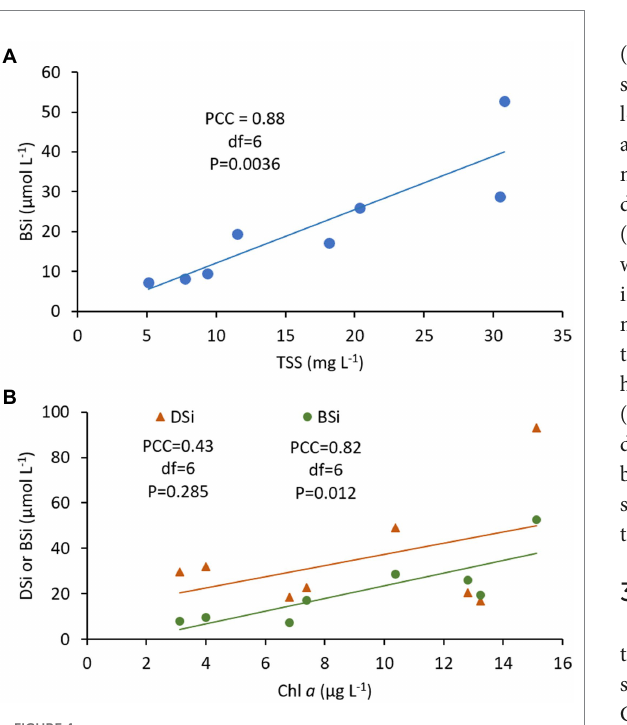
(Figure 6). The fine-grained dredged material substrate is the primary source of Si, with vegetation mining about half of the exported Si from the root zone.